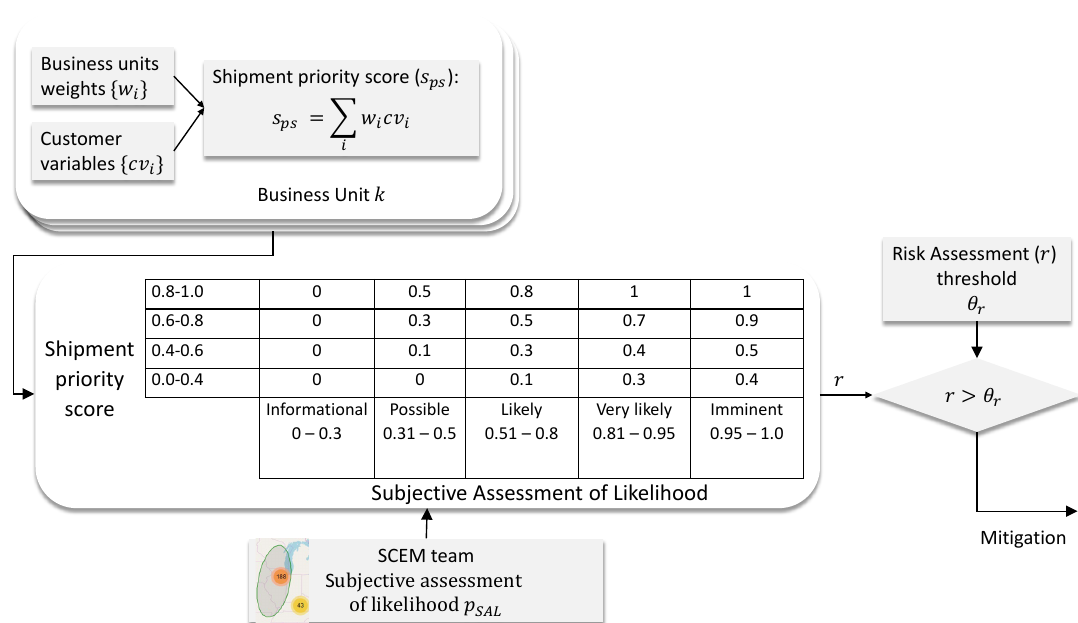
Figure 5. Risk assessment (RA) block